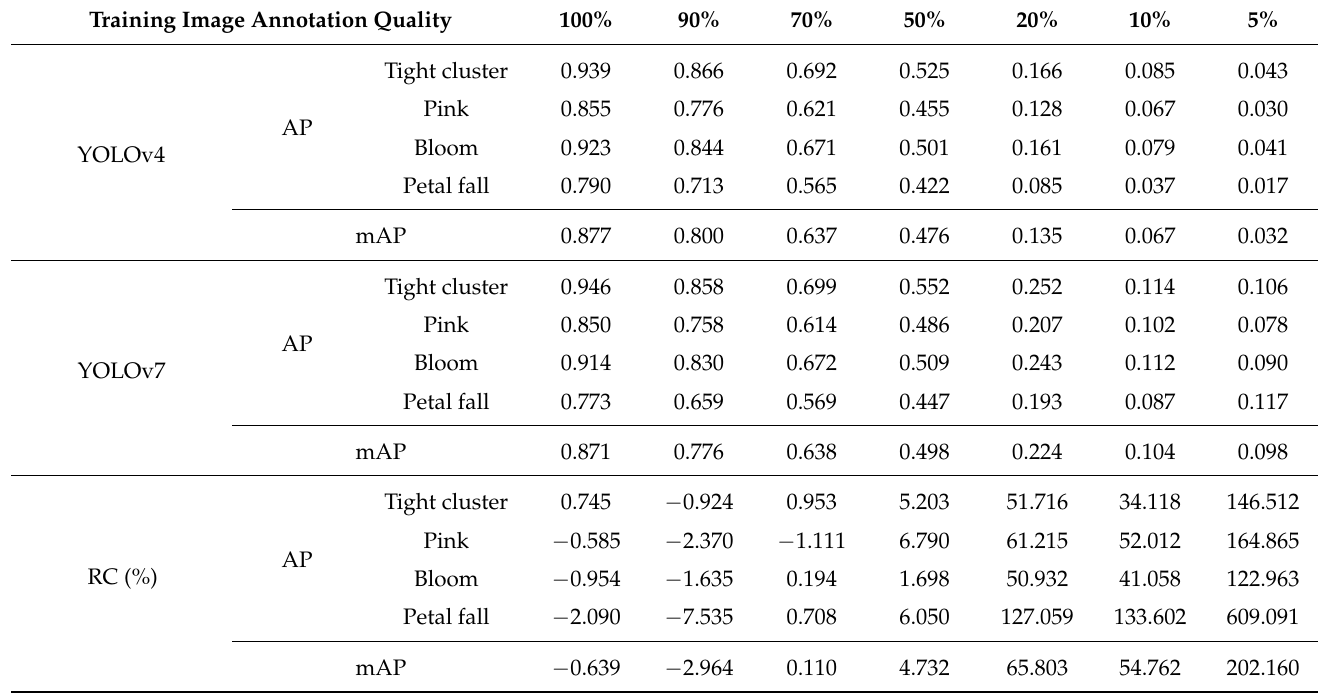
Table 1. YOLOv4 and YOLOv7 model performance comparison based on the training